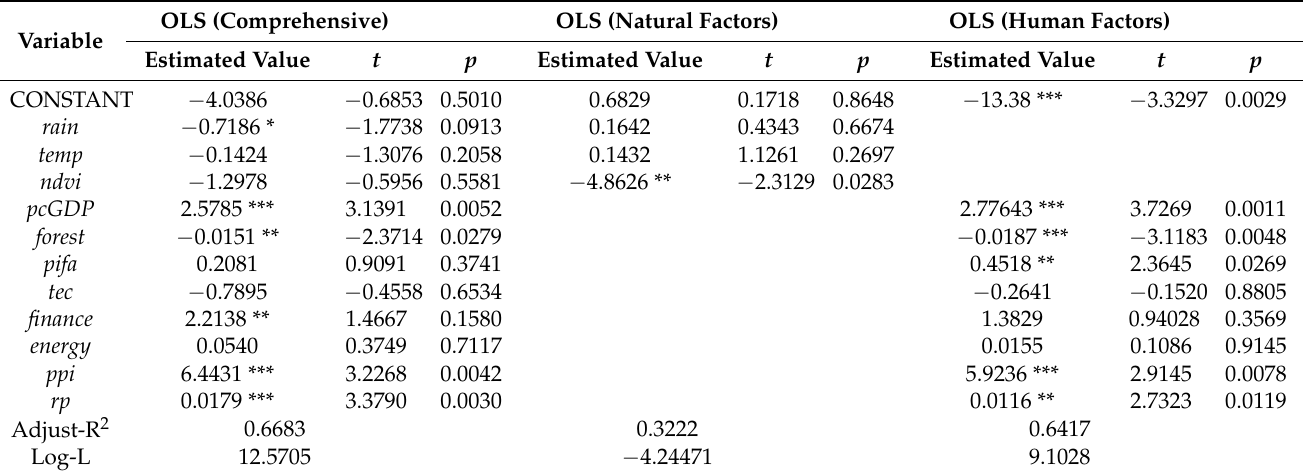
Table 7. Model estimation results.